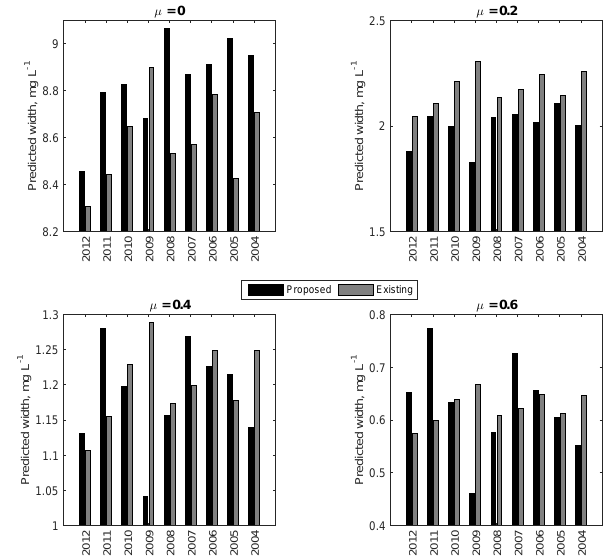
Figure 11. A comparison of average annual interval widths of pre- dicted fuzzy numbers using the proposed and existing FNN methods for four selected membership